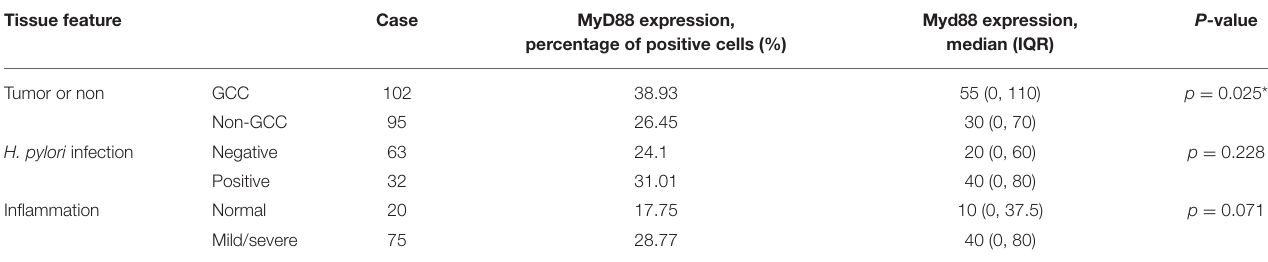
TABLE 1 | Immunohistochemical evaluation of MyD88 expression in different gastric cardia tissue. Tissue